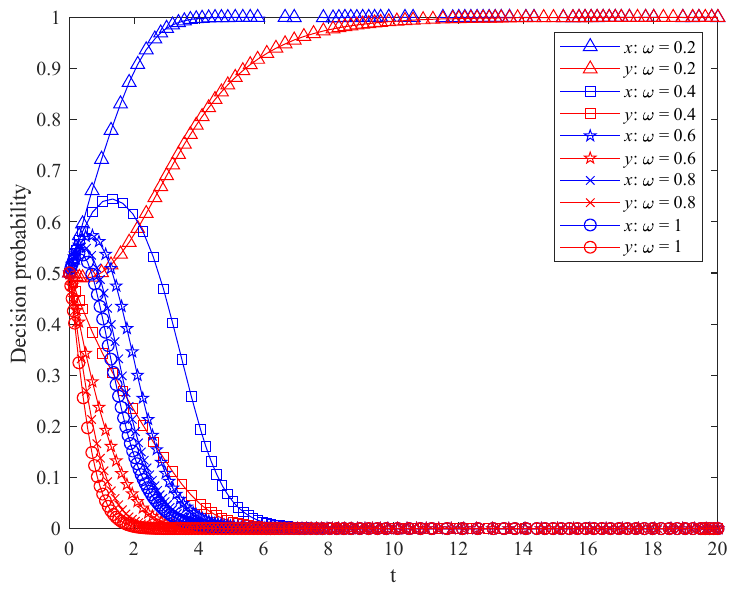
Figure 12. System evolution of 𝜔 = {0.2, 0.4, 0.6, 0.8, 1} .